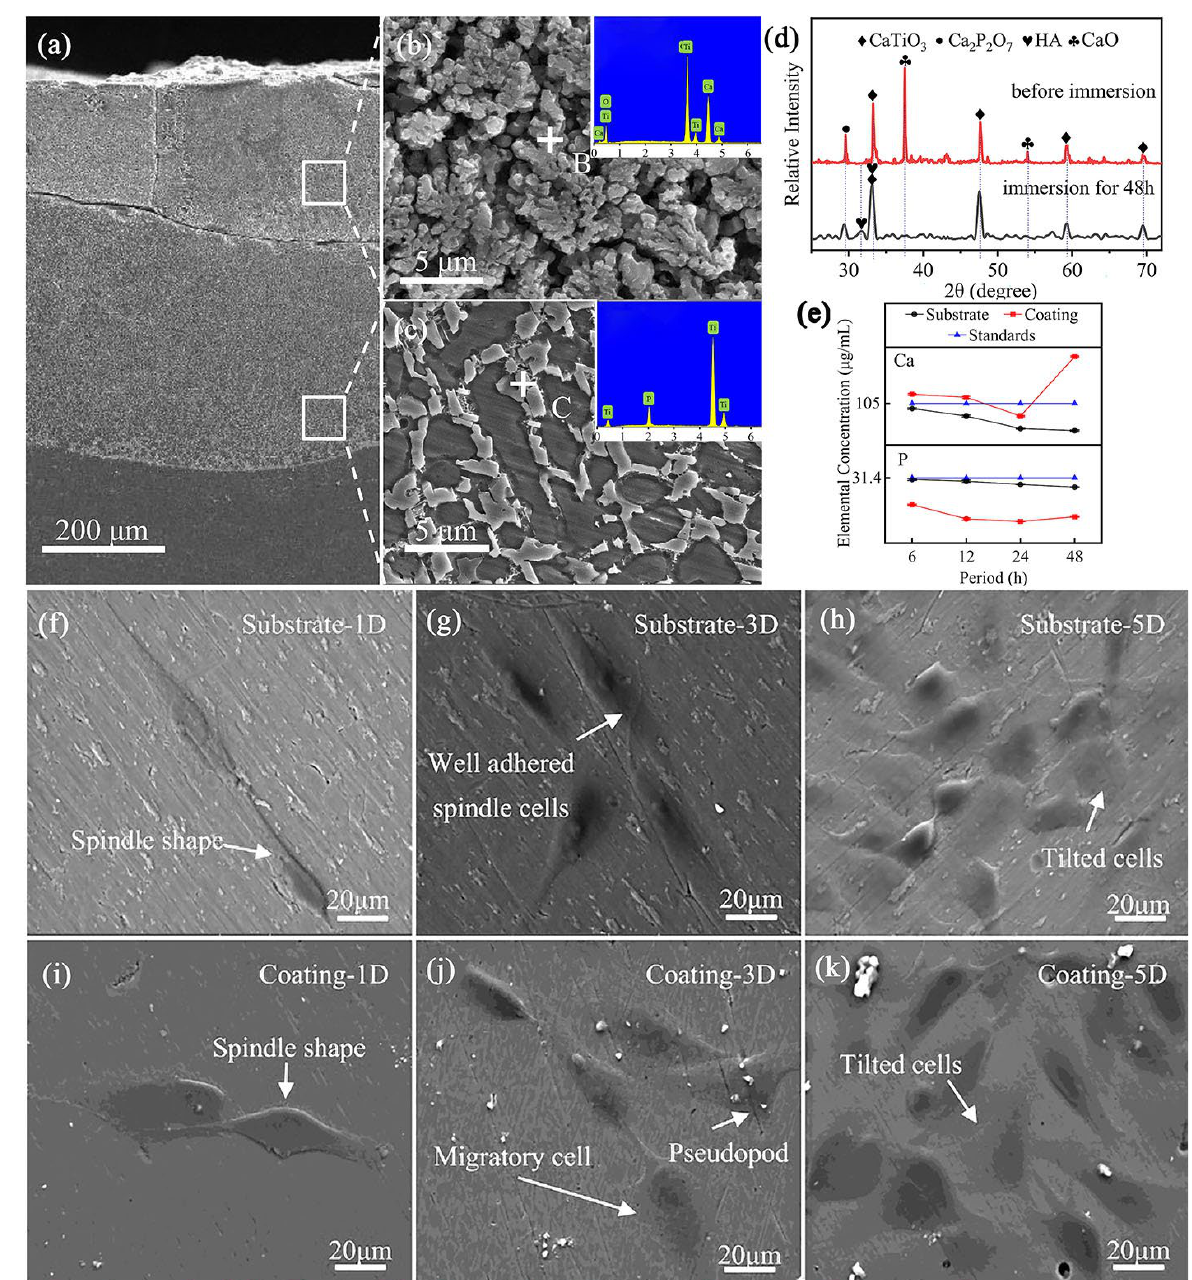
Figure 9. ( a ) The macrograph of the Ca/P ceramic cladding layer on the TC4 substrate; ( b ) microstructure and the EDS results at point B of the cladding layer; ( c ) microstructure and the EDS results at point C of the transition layer; ( d ) XRD patterns of the cladding layer with and without immersion; ( e ) Ca and P concentrations in the immersion solution with different specimens and time; ( f – h ) morphology of the cultured MG-63 cells on the TC4 substrate for 1, 3, and 5 days; ( i – k ) morphology of the cultured MG-63 cells on the Ca/P cladding layer for 1, 3, and 5 days [171]. Reprinted with the kind permission of MDPI.